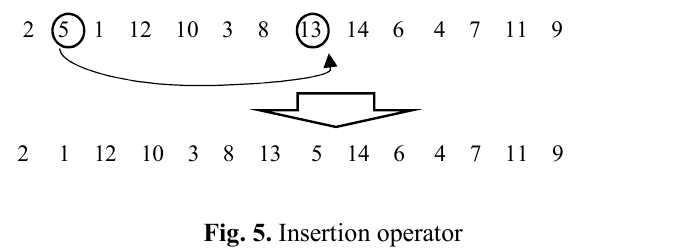
Fig. 5. Insertion operator